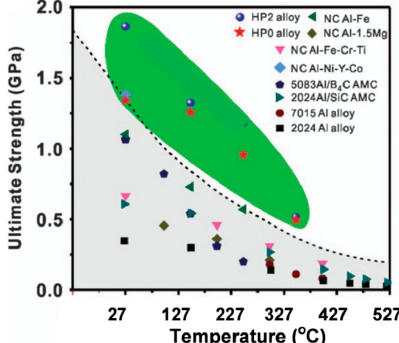
Figure 28. Thermal stability of the Al84Ni7Gd6Co3 (at.%) alloy, produced by a combination of gasification, ball milling and hot pressing as compared to other alloys taken from the literature. HP0—hot pressing at 640 MPa and T HP = 500 °C using gas-atomized powders; HP2—powders milled for 50 h (HP1) and 100 h [25].